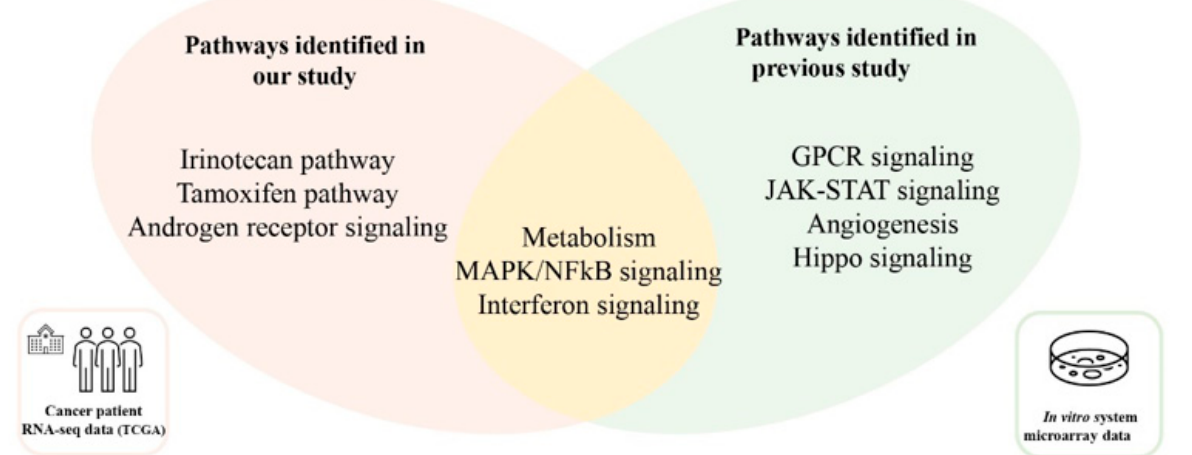
Figure 2. Gene-pathway network. Round rectangles are pathways, and ellipses are genes. The colors of the lines originate from the colors of each rectangle of the pathway.